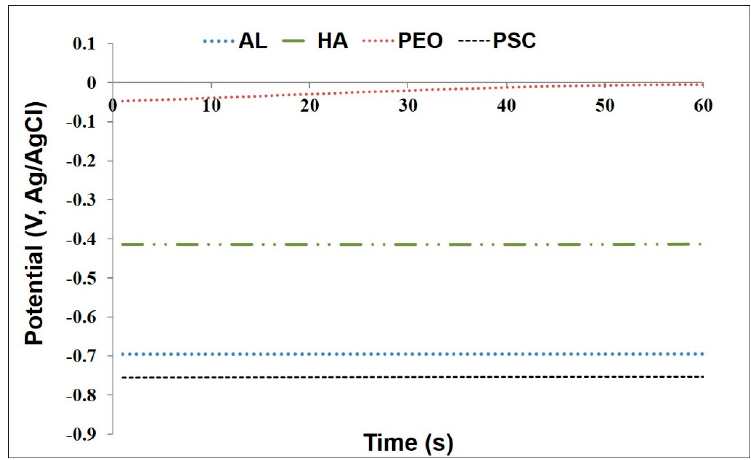
Figure 6. Initial Open Circuit Potential (OCP) measurements of the coating materials versus the Ag/AgCl reference electrode.